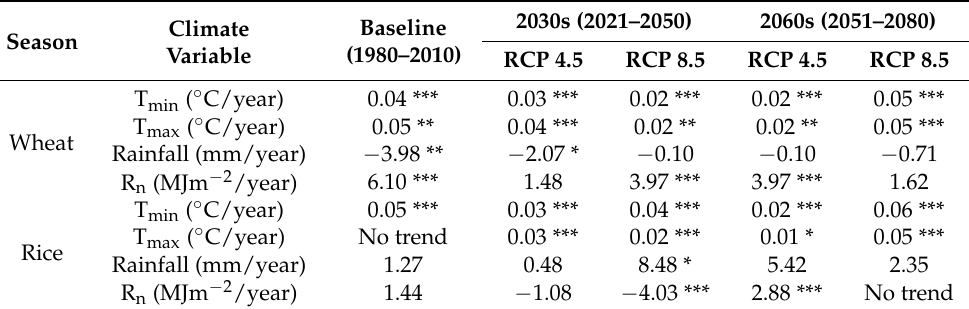
Table 1. Sen’s slope of the climate change trends for the wheat and rice seasons during the baseline and future time slices.